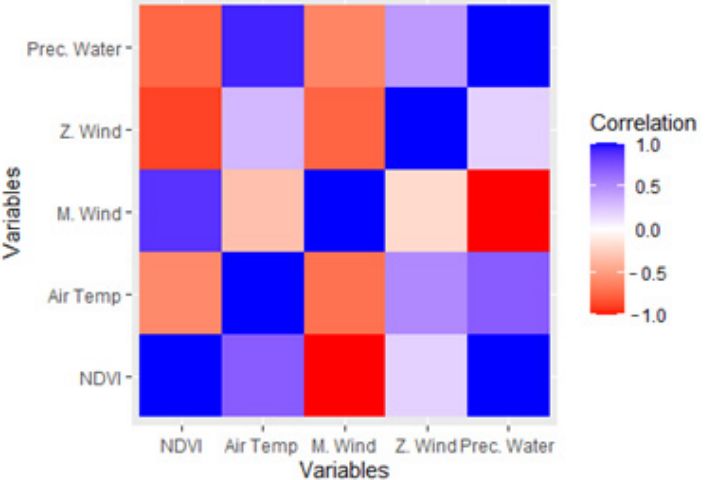
Figure 6. Correlations heatmap obtained for trend (values below the principal diagonal) and seasonality (values above the principal diagonal) components extracted from the time series of the reservoir mean NDVI and the climate variables: air temperature (Air Temp.), meridional and zonal wind (M. Wind, Z. Wind), and precipitable water (Prec. Water).